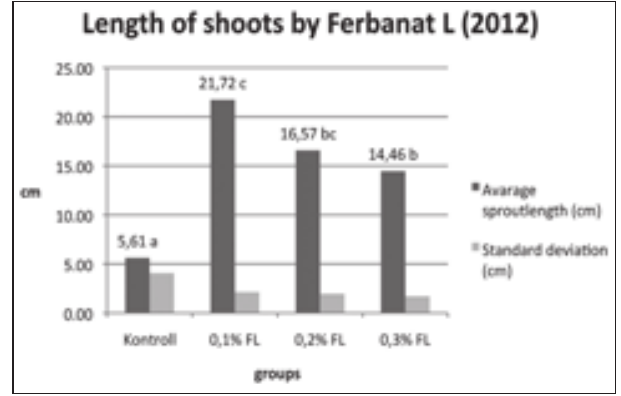
Fig. 1.: Length of sprouts by using Ferbanat L in Petunia x grandiflora ’Musica